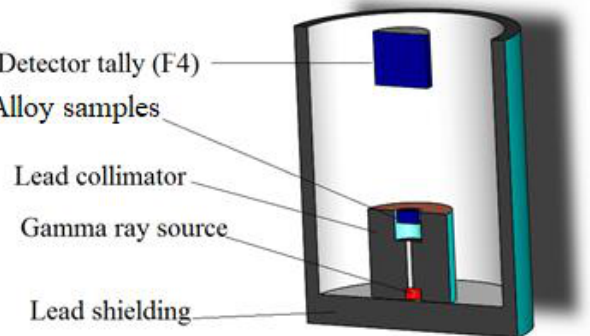
Table 1. The chemical composition of the selected alloys in (wt.%).